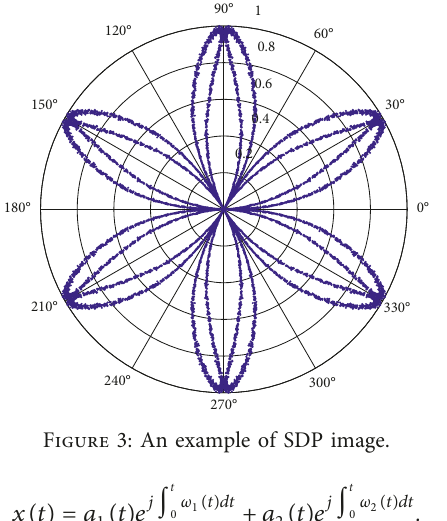
Figure 3: An example of SDP